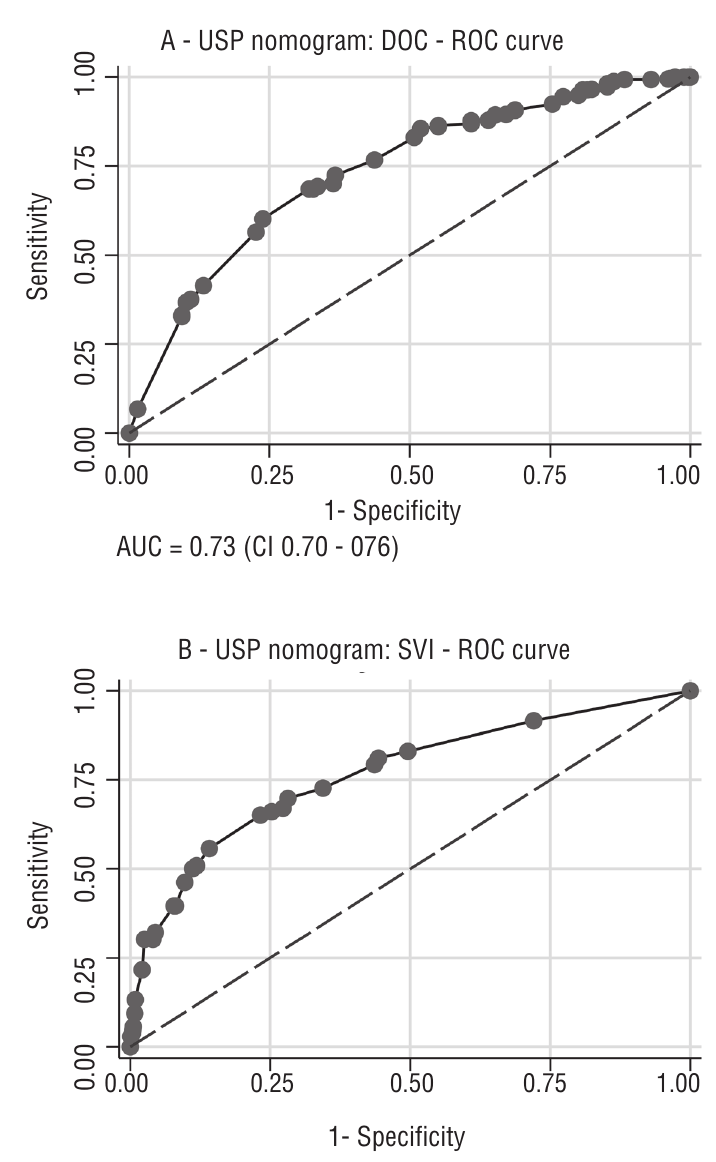
Figure 3 - ROC curves for prediction of OCD and